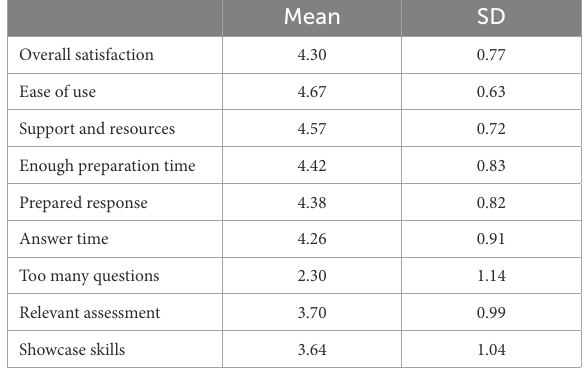
TABLE 8 Descriptive statistics of the user experience